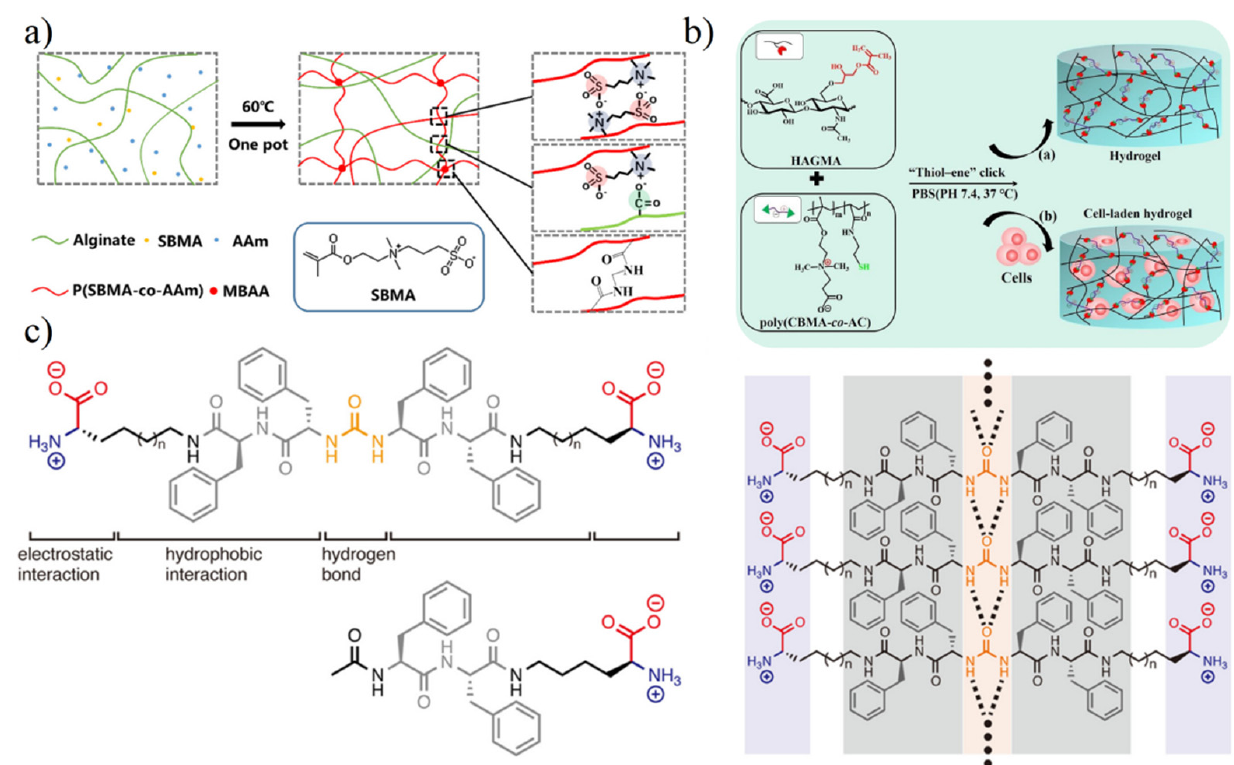
Figure 4. Methods for the formation of zwitterionic hydrogels. ( a ) In situ free radical polymerization using SBMA and acrylamide (AAm) monomers initiated by heat. Reproduced with permission from [44]. Copyright 2020 Wiley Periodicals LLC. ( b ) Polymer-coupling using thiol-ene click reaction without small molecules. Reproduced with permission from [36]. Copyright 2020 Elsevier Ltd. All rights reserved. ( c ) Self-assembly using urea bond to form a strong hydrogen bond network. Reproduced with permission from [42]. Copyright 2020 Wiley Periodicals LLC.